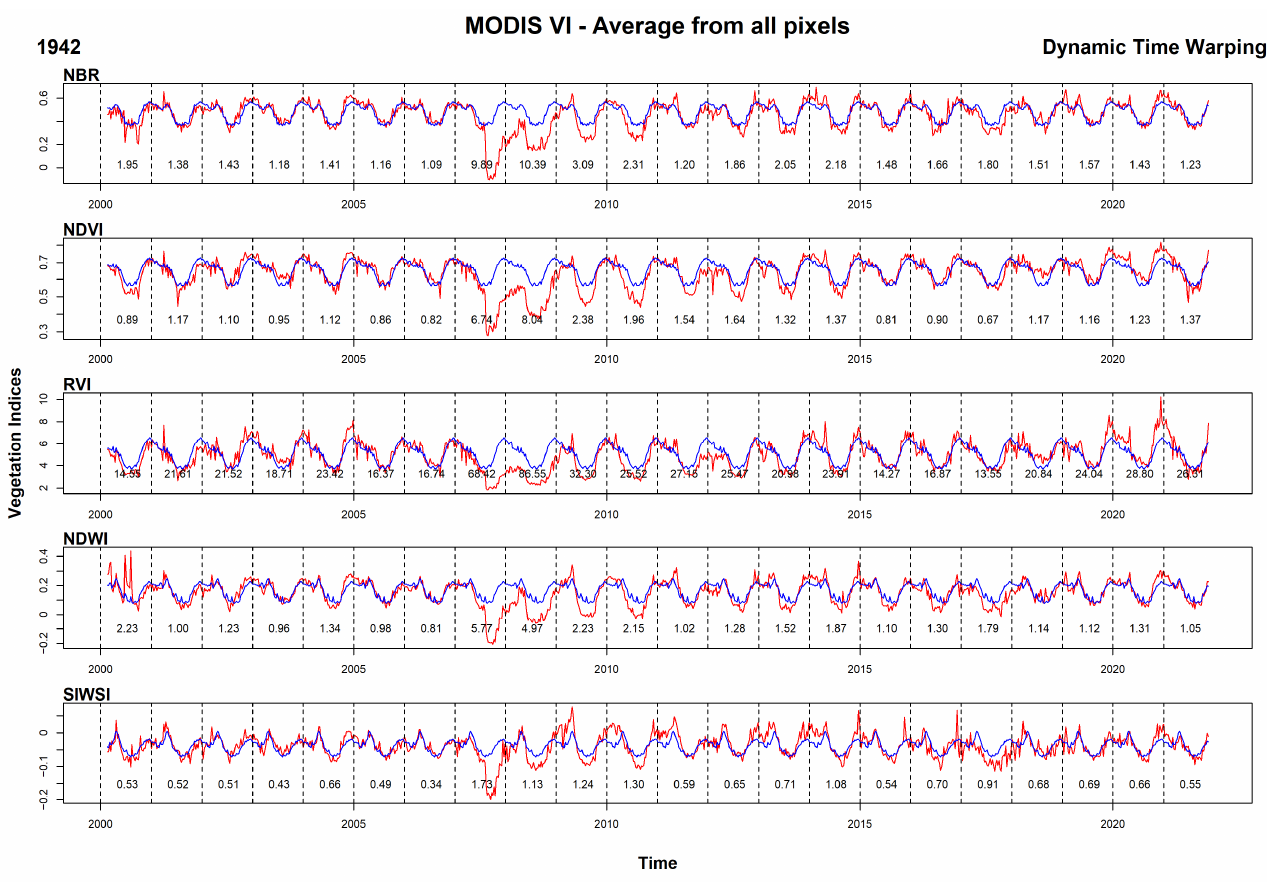
Figure 13. For the delineated fire perimeters, a phenological pattern of the burned areas was created, as a result of the analysis of the time series of the radiometric values of each spectral channel and each vegetation index. The phenology of the areas before (blue line) and after (red line) each fire incident was compared to each other by estimating their distances with the dynamic time warping method.